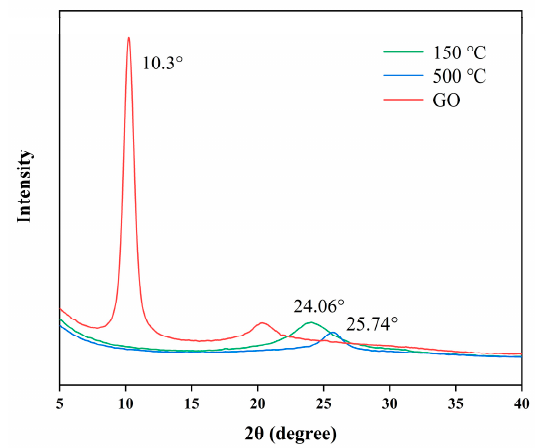
Figure 7. X-ray diffraction spectra of GO and RGO before and after heat treatment. From the microscopic morphology of the RGO sheet, the surface of the RGO sheet was rough, rippled, and folded at 150 ◦ C drying (see Figure 8a,b). Up to 500 ◦ C, rougher and with warped sheets of fibers, the dense accumulation of the layers was extremely spaced, possibly from the expansion caused by the escape of gas from the desorption process (see Figure 8c,d).